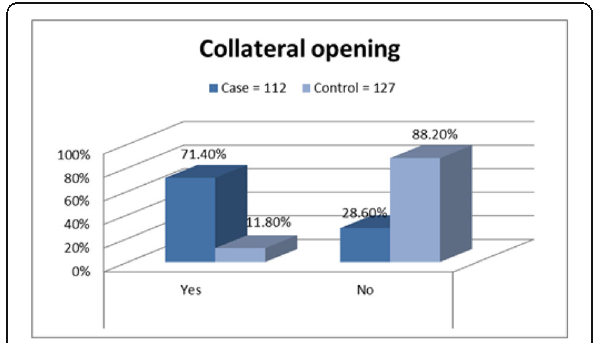
Fig. 1 (abstract P65). See text for